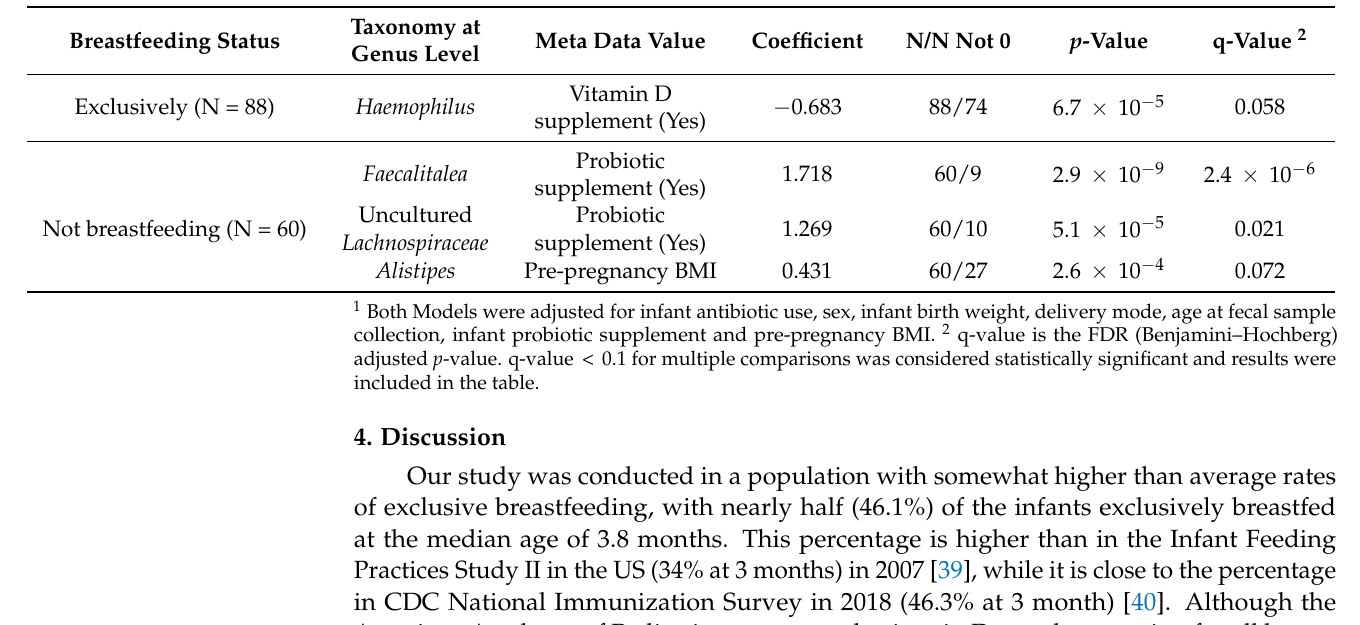
Table 5. MaAsLin Analysis Results: Associations of infant feeding practices and gut microbiome taxa at genus level. adjusted by covariates within exclusively breastfed and no breastfed infants 1